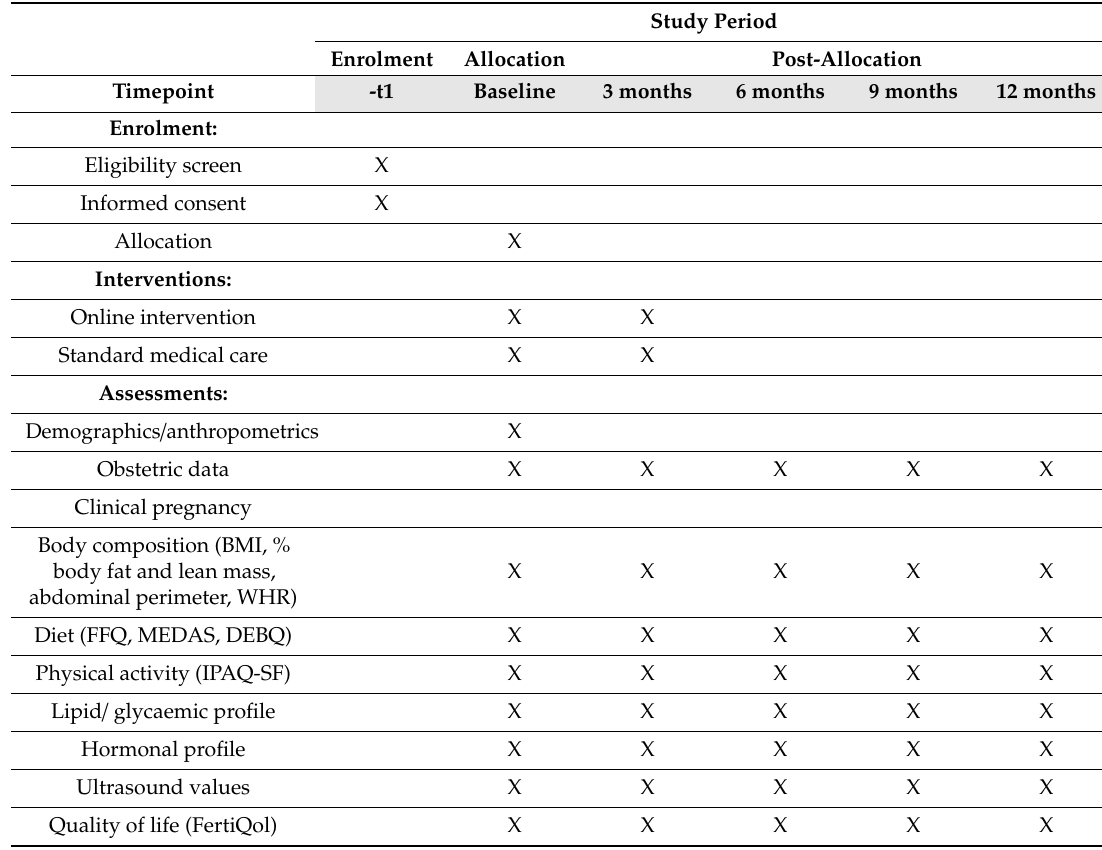
Table 1. Outcomes and timings of assessments for each outcome. Study Period Enrolment Allocation